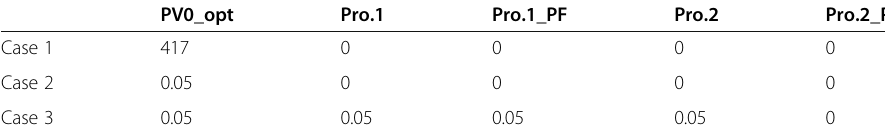
Table 9 Voltage violation amounts at 12 analysis points (V ∙ min)